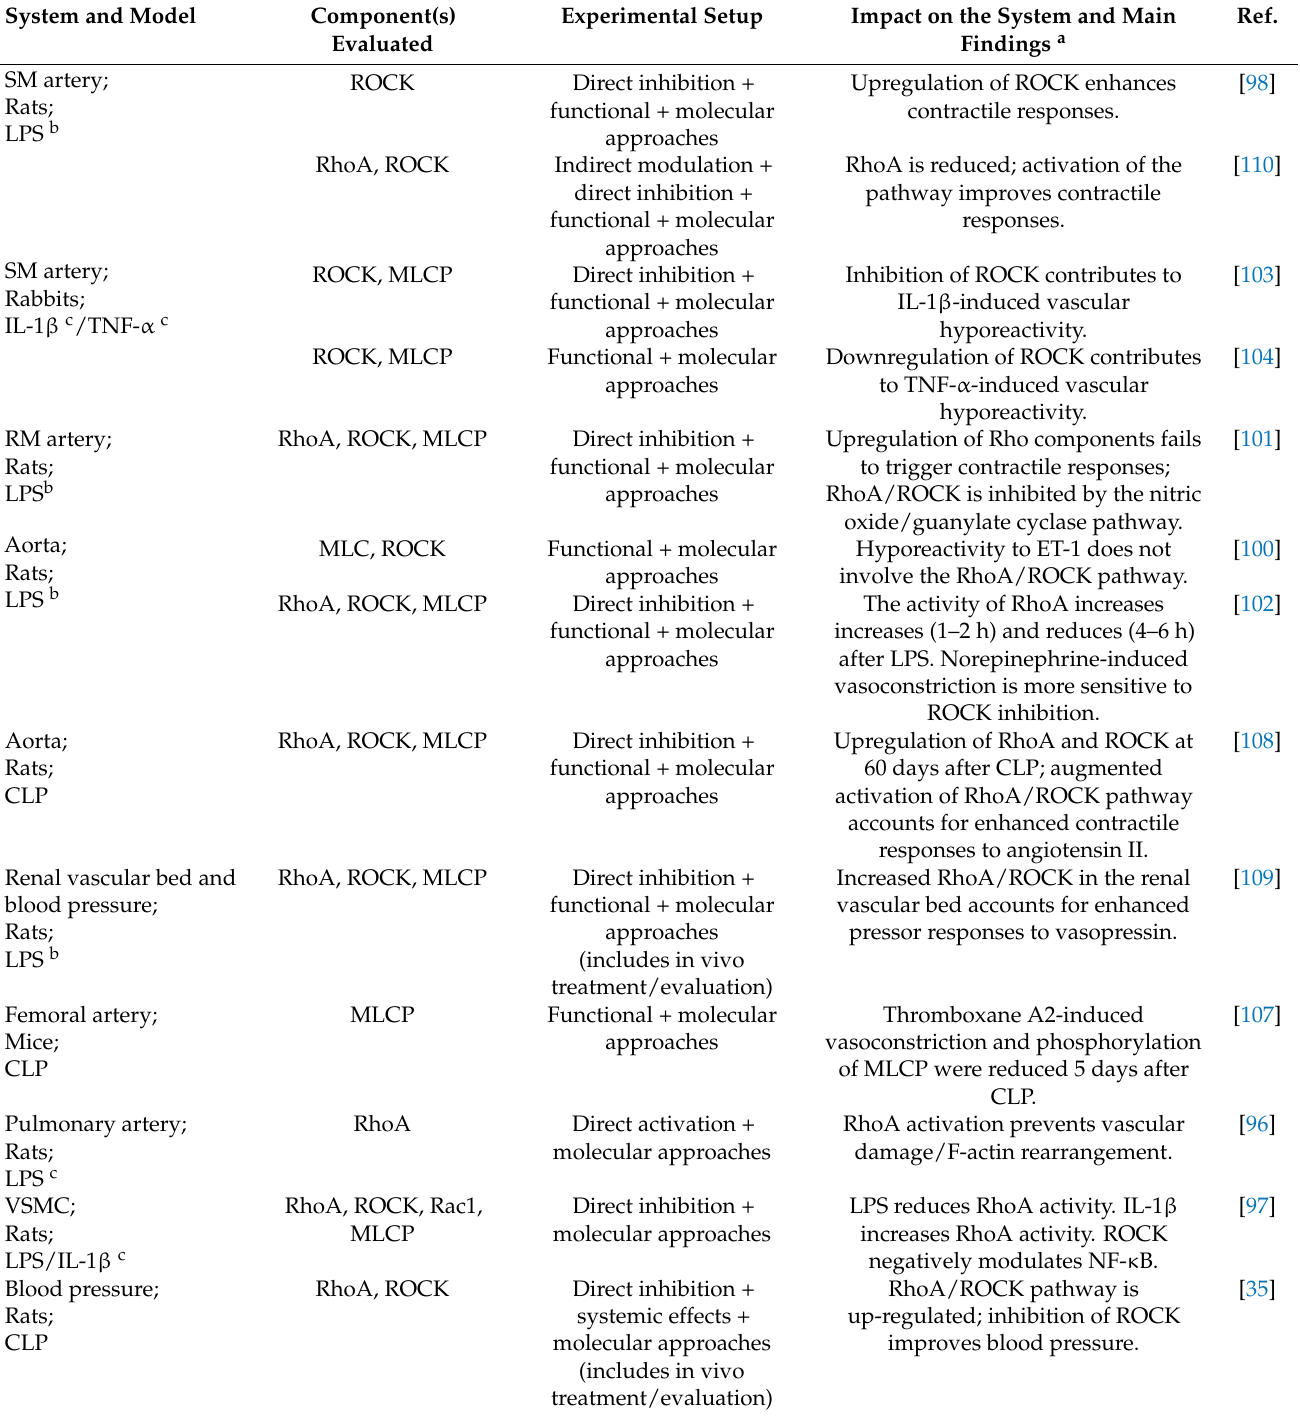
Table 2. The involvement of Rho proteins and downstream pathways in the cardiovascular function as found in sepsis- associated experimental